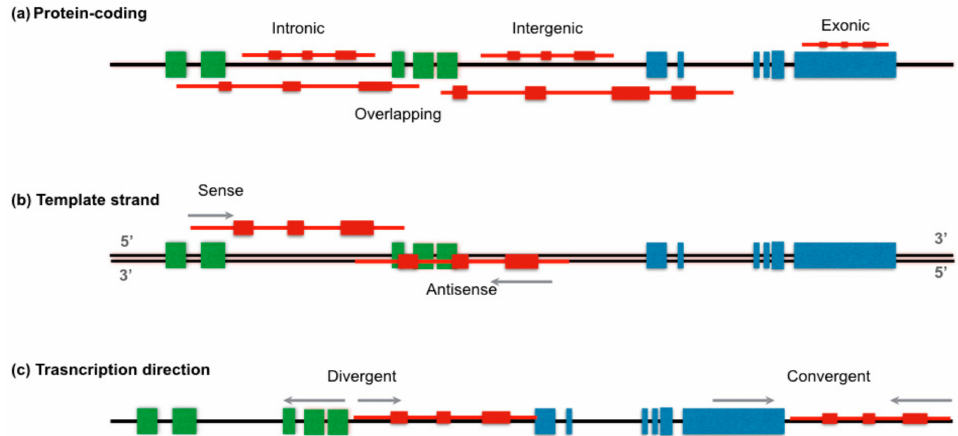
Figure 1. Positional classification of the long non-coding RNAs (lncRNA). Carton displays the LncRNA (red) classification base on ( a ) the location between two coding genes (intronic, exonic, intergenic, or overlapping), ( b ) the template strand (sense, antisense), and ( c ) transcription direction when coding genes and lncRNA are transcribed in the same strand (divergent, convergent). Gray arrow indicates in which direction transcription is proceed. Green and blue boxes represent exons of two different genes.